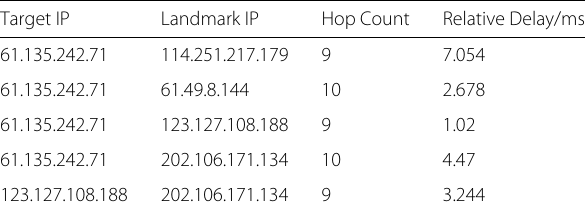
Table 1 Measurement results of 61.135.242.71 and